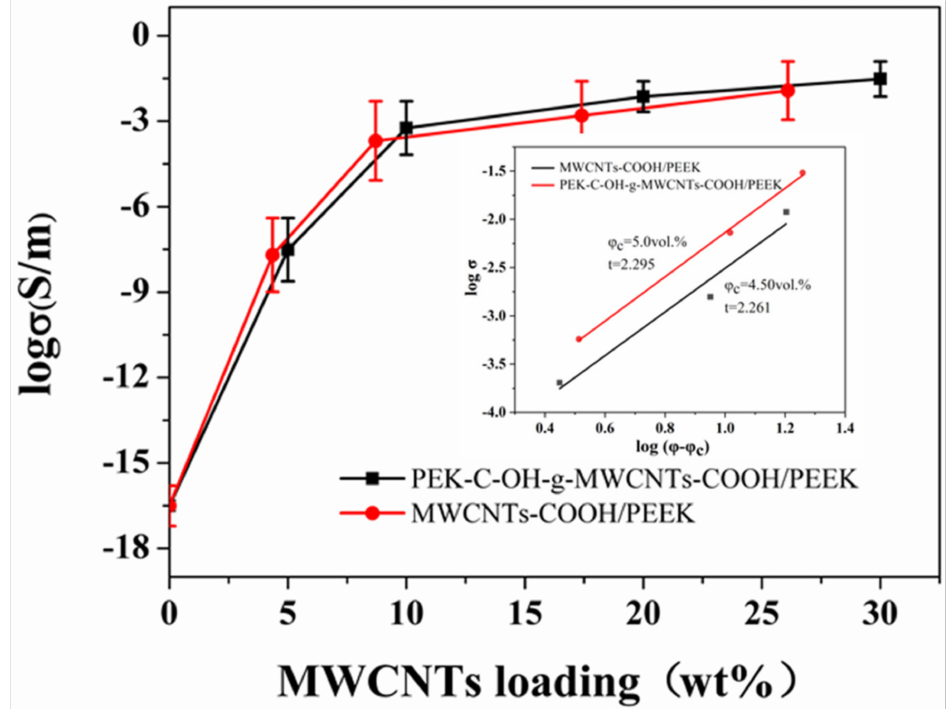
Figure 10. Electric conductivity of MWCNTs/PEEK